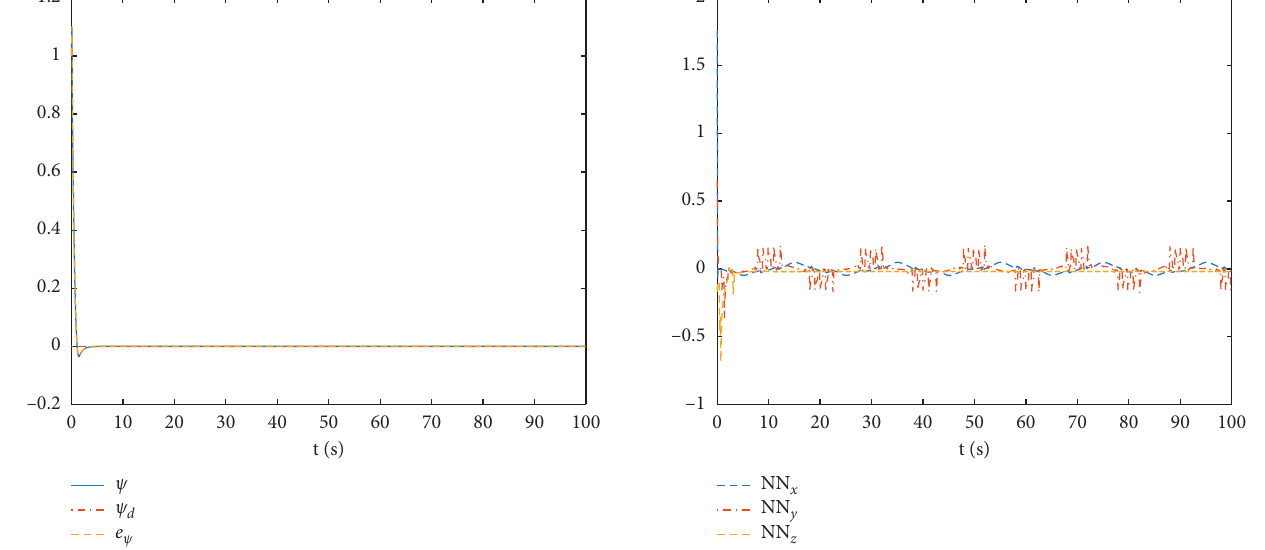
Figure 8: Trajectories of attitude ψ , ideal position ψ